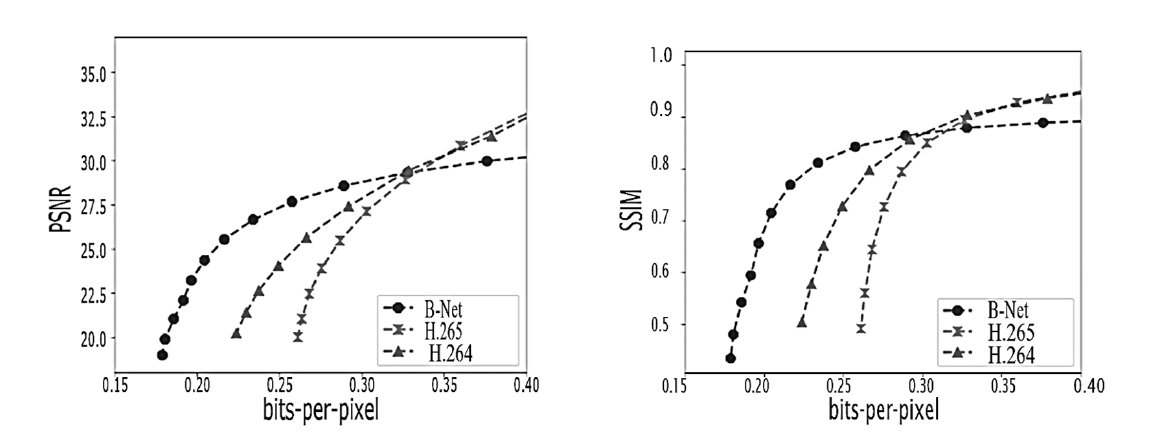
Fig. 7. Comparison graph of PSNR and SSIM for P-net with existing techniques.